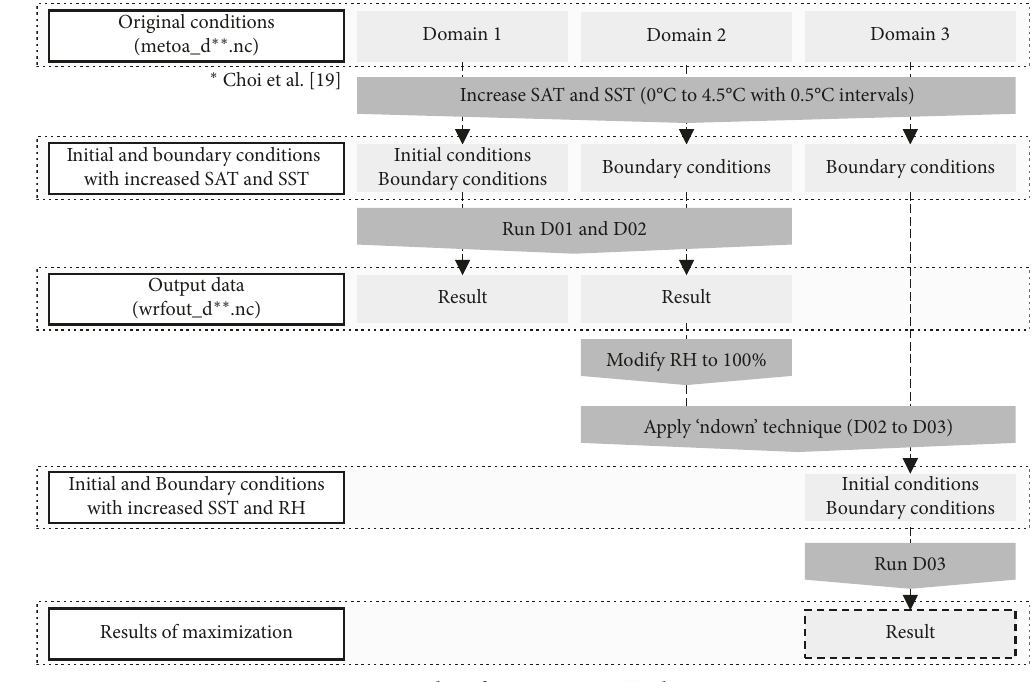
Figure 3: Procedure for maximizing Typhoon